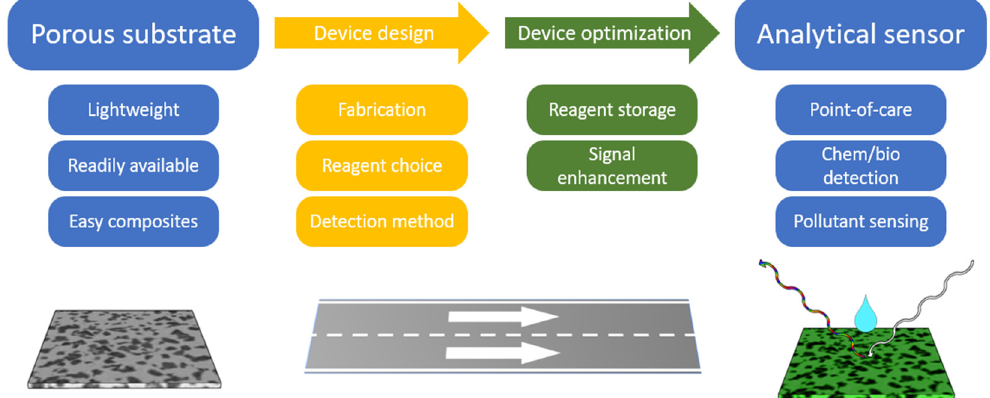
Figure 1. Key benefits of porous materials and considerations for their use in constructing sensing devices. Table 1. Representative examples of sensing devices that utilize porous composite materials.